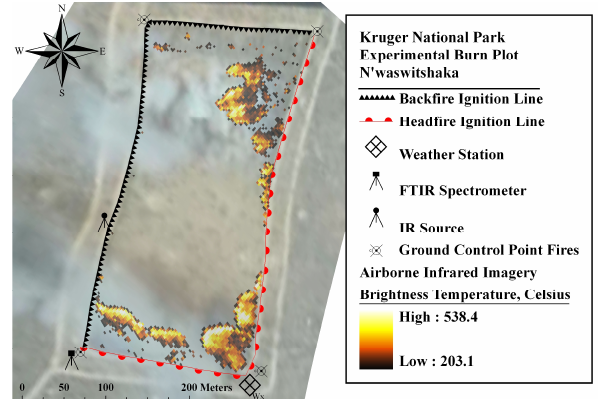
Fig. 1. Typical field setup deployed here to study the smoke char- acteristics of southern African savannah fires using OP-FTIR spec- troscopy. Data are from a period less than halfway through the du- ration of Fire 1 (Table 1), when the flaming front had only transited across approximately one quarter of the total plot area. Background view is a frame captured from the near vertically-viewing optical video record made from the hovering helicopter, where the burn plot can be seen to be surrounded by a semi-rectangular fire break (lead- ing to a dirt road bottom left). The smoke plume (grey) generated here mainly by the head fire lit on the eastern and southern sides of the plot, can be seen blowing toward the west. Superimposed on this optical image is the map of pixel brightness temperatures recorded via an airborne AGEMA-550 infrared camera. Only the locations of ground pixels whose IR brightness temperature (BT) exceeds 203 ◦ C (476K) are displayed, corresponding to areas of active combustion. Higher BTs are generally seen at the fire fronts (likely flaming areas), whereas lower BTs are recorded behind the fronts, i.e. in the “smoking zone” identified by Lacaux et al. (1996) where combustion rate and thus heat release is lower (Fig. 2). It should be noted that BTs are unlikely to represent actual fire tem- peratures since the flames may under-fill pixels (see e.g. Wooster et al., 2005). The smoke plumes can be seen to emanate from ar- eas of active combustion identified by the IR-camera record. The backfire (downwind) and headfire (upwind) ignition lines are indi- cated, as is the location of the FTIR spectrometer, IR source and weather station. All imagery and spatial locations were positioned using GPS records and/or ground control points identified in either the optical or IR camera records. From the shadow of the plume on the ground, and the location of the sun, the plume height over the plot is estimated at ∼